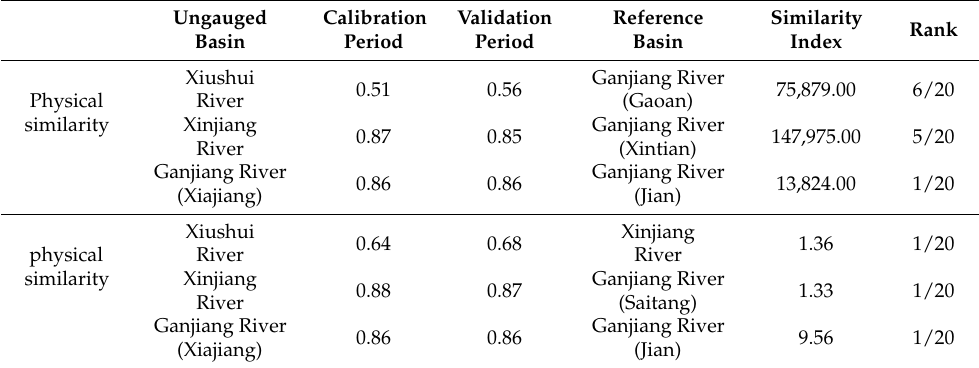
Table 6. Parameter transfer efficiency of the Poyang Lake Basin based on physical similarity and spatial